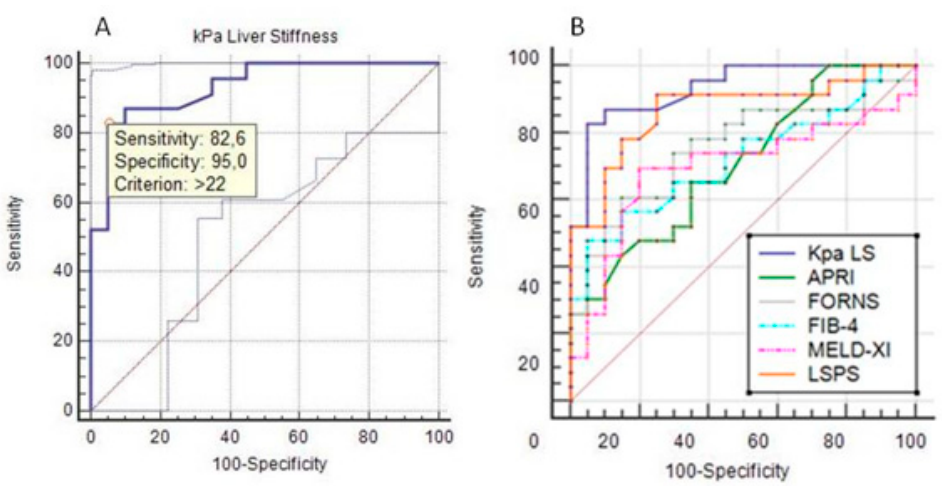
Figure 2. ( A ) ROC curve for identification of the LS (kPa) cut-off for diagnostic accuracy prediction of cases with advanced FALD. The values > 22 kPa were related, with 82.6% sensitivity and 95% specificity to cases with advanced FALD. ( B ) Comparison of diagnostic accuracy by ROC curves among LS and conventional scores used to stage liver disease.